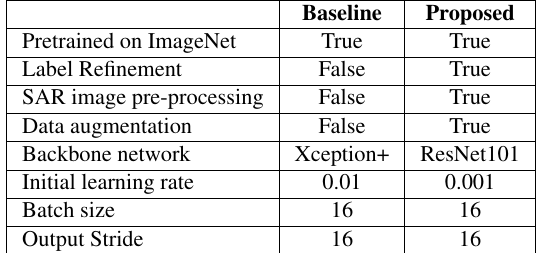
Table 2: Parameters setting of the baseline model and the pro- posed